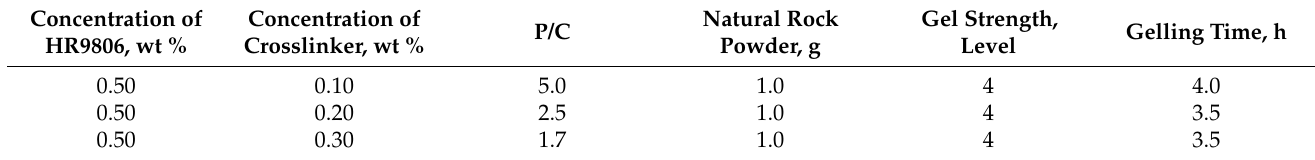
Table 3. Effect of natural rock powder on the gelling effect of the system.